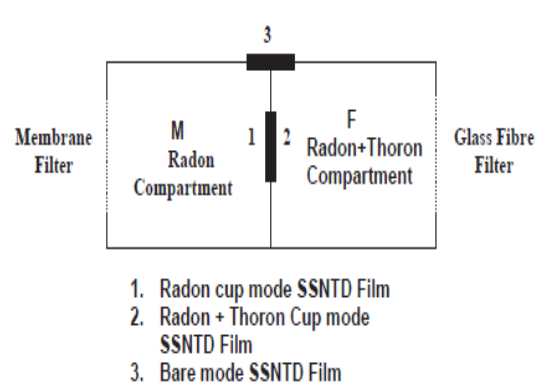
Fig 1: Twin cup radon–thoron